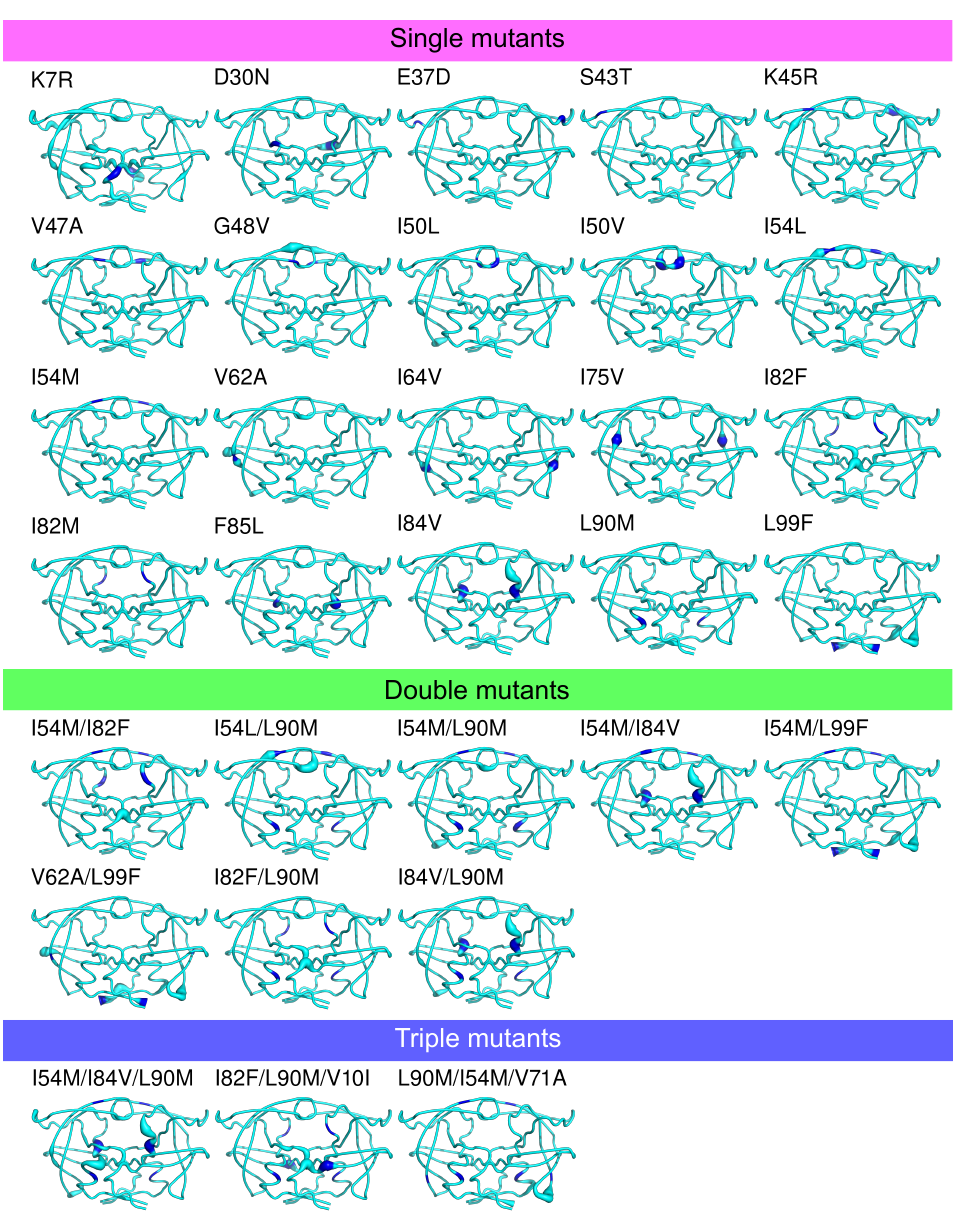
Figure A3. Location of the MCS atoms found in each mutant. PR2 is colored in cyan and represented in putty mode. The putty radius is relative to the deformation induced by mutations: the higher the radius, the stronger the mutation-induced rearrangement. Mutated residues are colored in